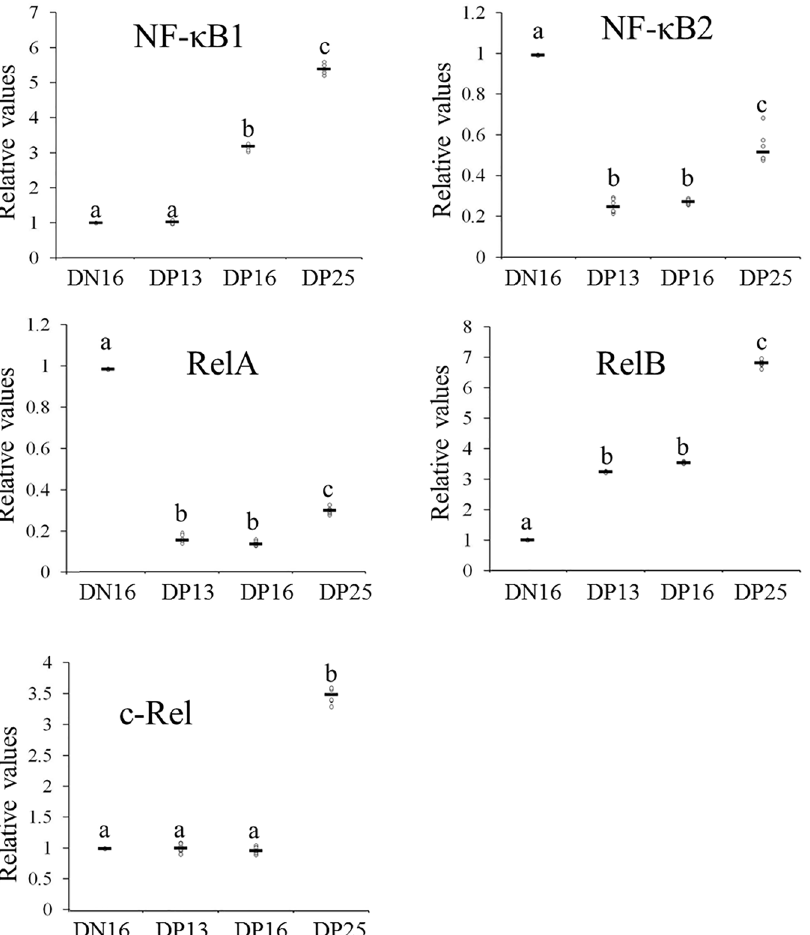
Figure 1. Relative expression values of NF-κB1 , NF-κB2 RelA , RelB , and c-Rel mRNA in the thymus from non- pregnant and pregnant ewes (n = 6 for each group). Note: DN16 = day 16 of the estrous cycle; DP13 = day 13 of pregnancy; DP16 = day 16 of pregnancy; DP25 = day 25 of pregnancy. Significance is denoted by letters; if two groups have different letters, this indicates that the difference between these groups was significant with P <